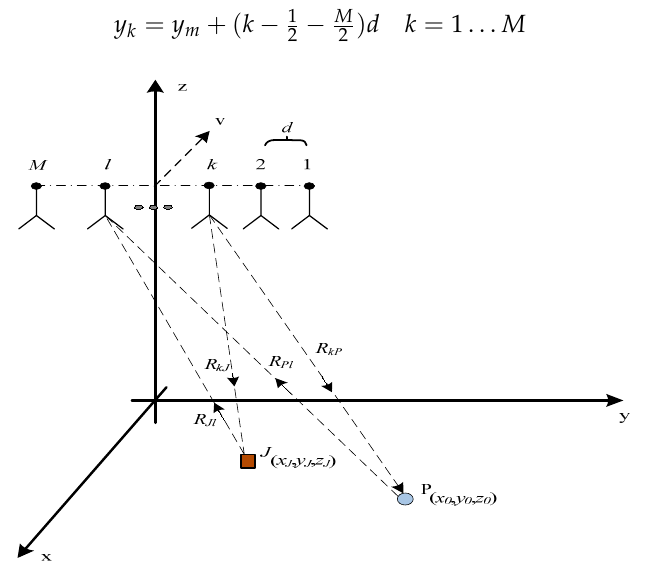
Figure 1. The Range MIMO SAR geometry model.